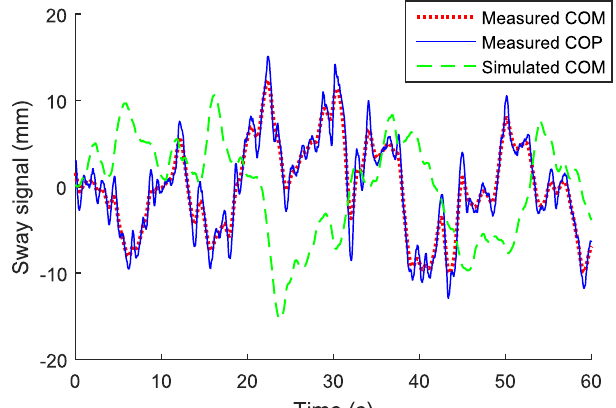
Figure 2. Manifestation of measured COP and COM signals, and of a simulated COM signal. The measured COM is calculated from the COP signal using Eq.